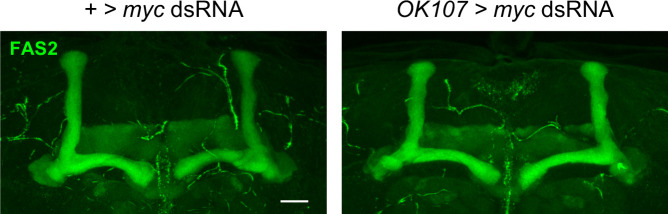
Knockdown of myc within Kenyon cells does not result in morphological defects of the mushroom body.Representative α/β lobe Z projections of adults expressing myc dsRNA driven by OK107-Gal4. No gross morphological defects were detected in the KD or control conditions n = 29–30.